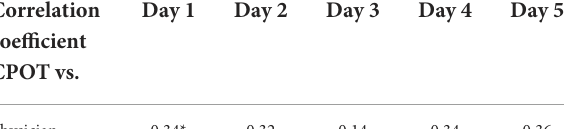
TABLE 3 Correlation between CPOT pain evaluation and procedures at each